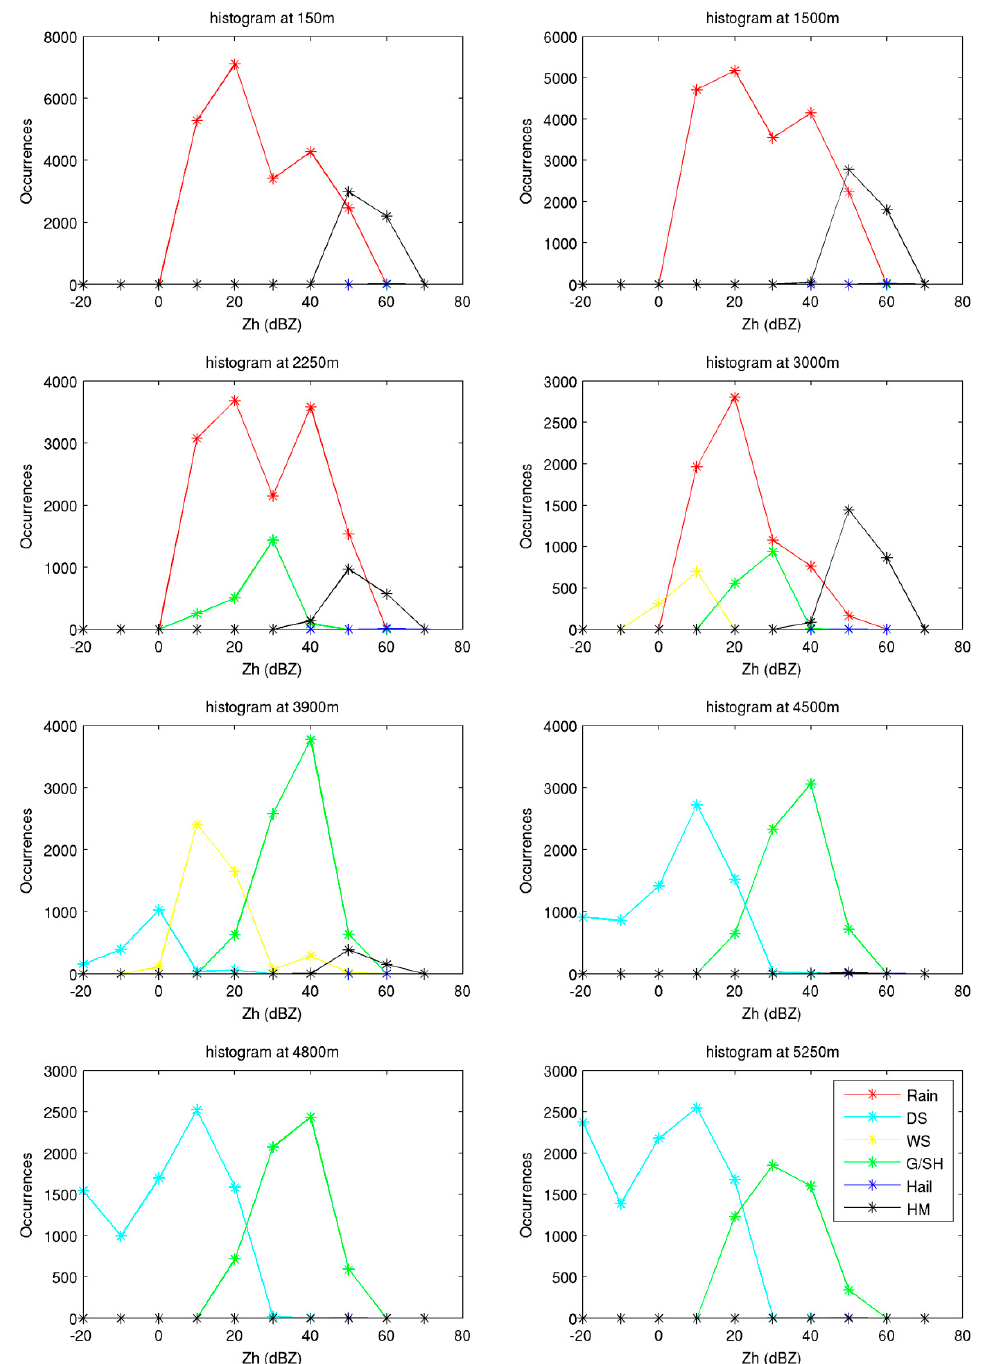
Figure A2. As for Figure A1, but the classification method is